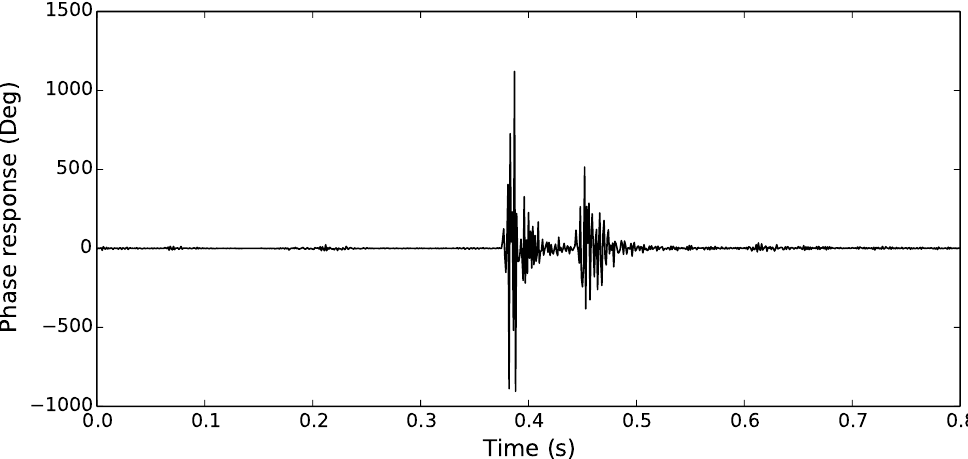
Figure 9. Time recording of a calibrated stroke at a distance of 1 m from the interferometric sensor being